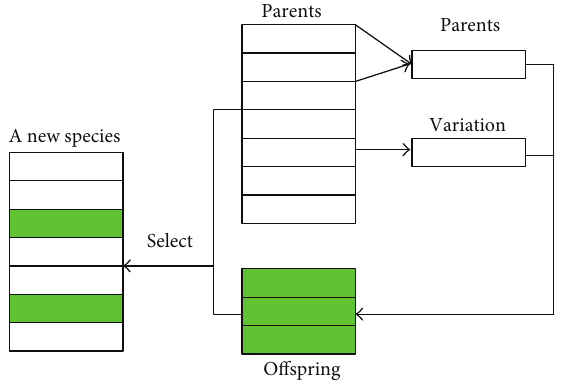
Figure 4: The choice diagram based on the expanding sampling